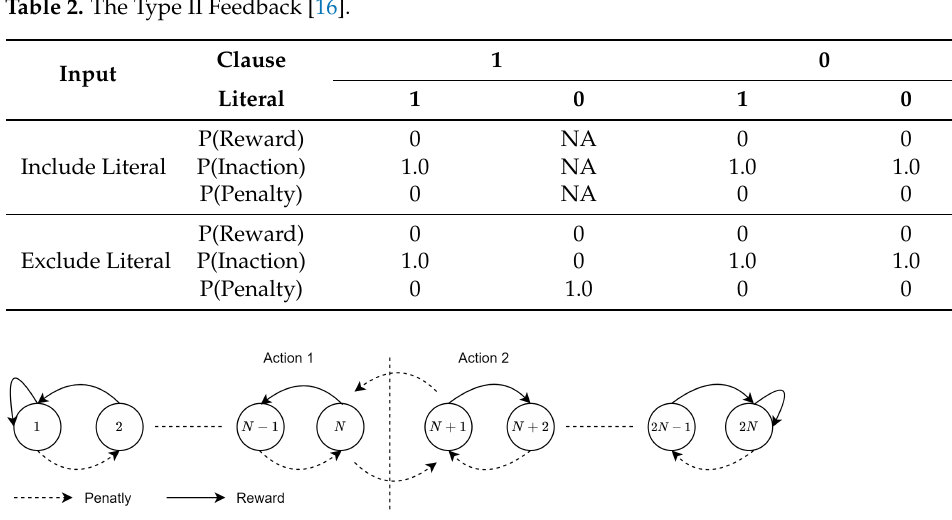
Figure 1. The two-action TA and its transition in